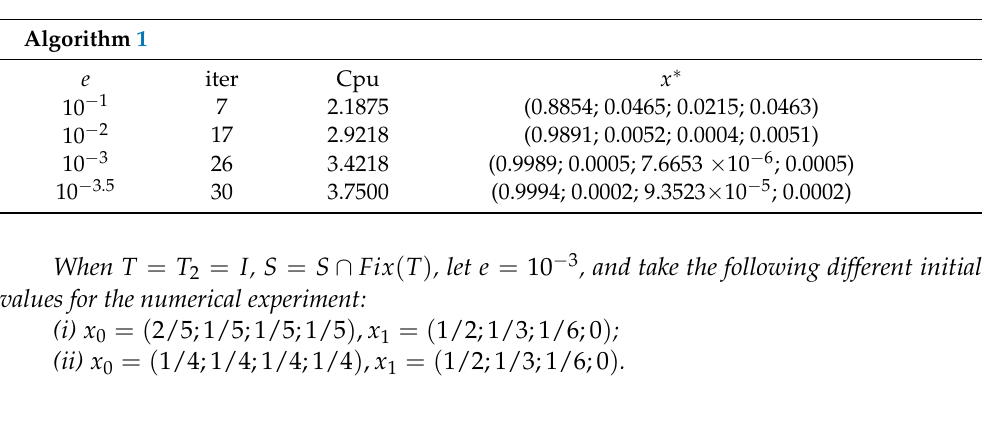
Table 1. The numerical result under T = T 1 in Example